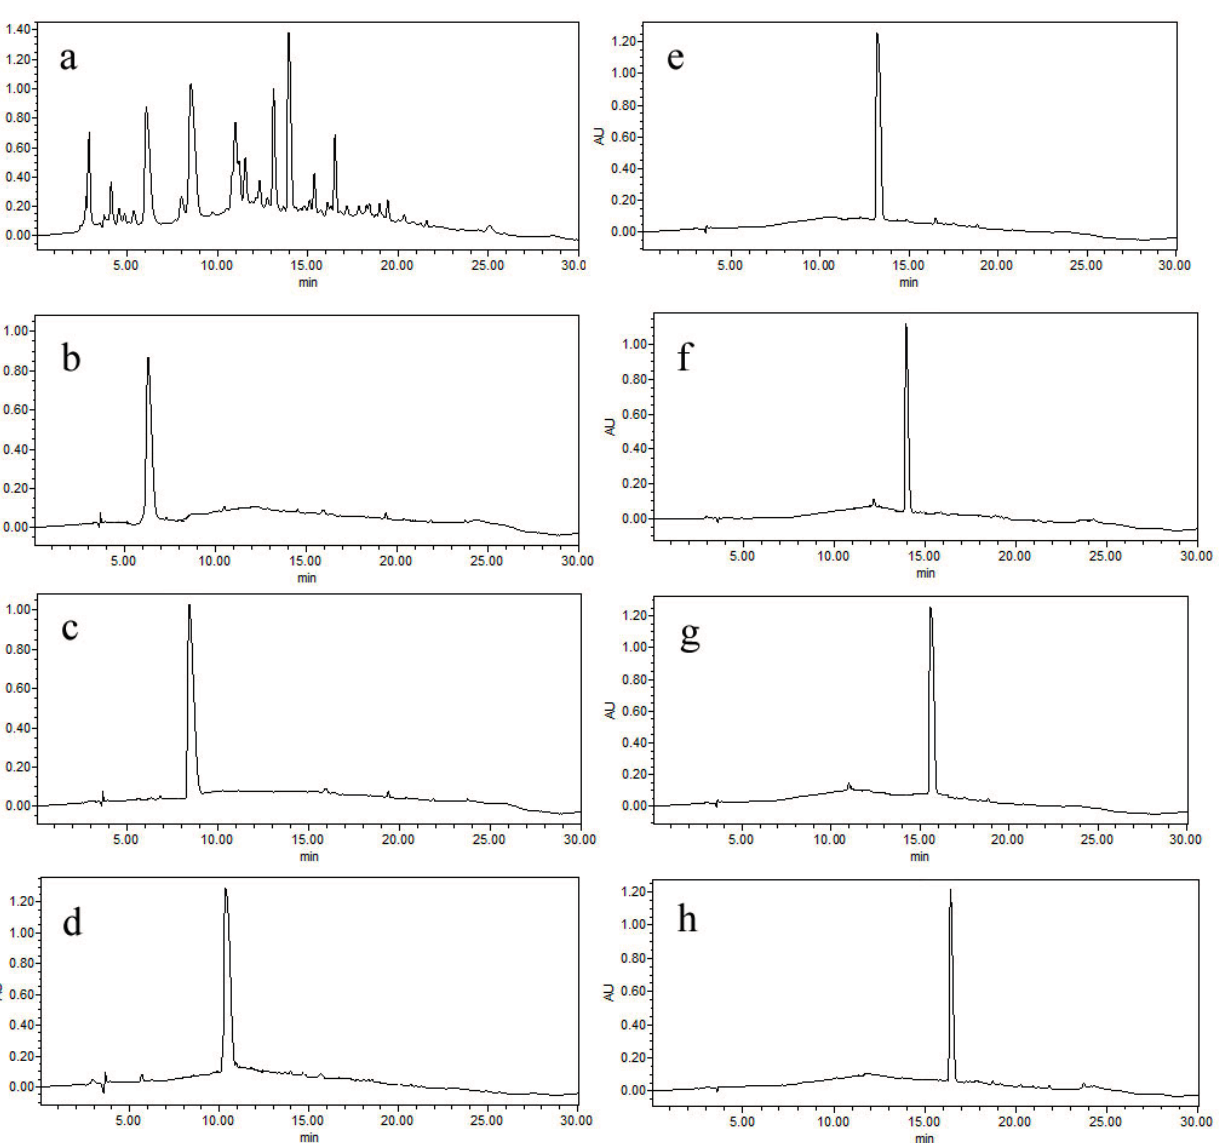
Figure 3. HPLC chromatograms: ( a ) Crude extracts from Aconitum coreanum ; ( b ) GFI; ( c ) GFA; ( d ) atisine; ( e ) GFF; ( f ) GFG; ( g ) GFR; ( h ) GFP; Column: Warters SymmetryShield TM RP18 column (250 mm × 4.6 mm I.D., 5 μ m); Mobile phase: